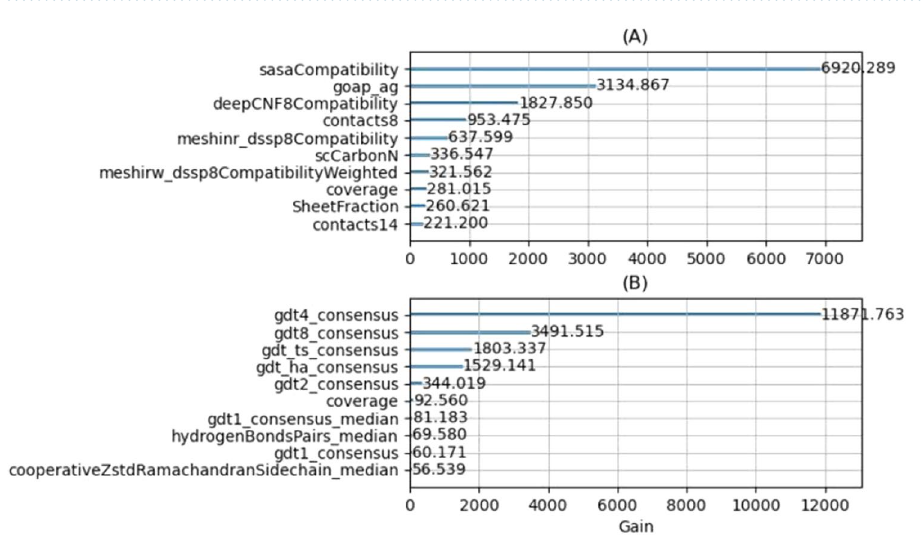
Figure 5. The ten most important (highest “GAIN”) features considering only the basic features (A) and all features (B) . The features from top to bottom: sasaCompatibility—a measure of the agreement between the solvent accessible surface area of the model’s residues (as measured by DSSP 65 ) and their predicted accessibility 56 . goap_ag—a pairwise orientation-dependent knowledge-based potential 40 . deepCNF8Compatibility—a measure of the agreement between the secondary structure (8 states) of the model’s residues (as measured by DSSP 65 ) and their predicted secondary structure 66 . contacts8 and contacts14—the average numbers of contacts with thresholds of 8 Å and 14 Å, respectively, between carbon atoms. meshinr_ dssp8Compatibility and meshirw_dssp8Compatibility_Weighted—two slightly different measures of the agreement between the secondary structure (8 states) of the model’s residues (as measured by DSSP 65 ) and their predicted secondary structure 59 . scCarbonN—the number of carbon atoms in the model’s side-chains. coverage—the fraction of the target sequence, which the are modeled. SheetFraction—the fraction of beta-sheet resides within the residues with any secondary structure. consensus features—see Eqs. (1–4). gdt1_consensus_ median—the median value of gdt1_consensus, among all the models of a specific target. hydrogenBondsPairs_ median—the median value of a cooperative hydrogen bonds energy term 67 among all the models of a specific target. cooperativeZstdRamachandranSidechain_median—the median value of a cooperative torsion angle energy term, among all the models of a specific